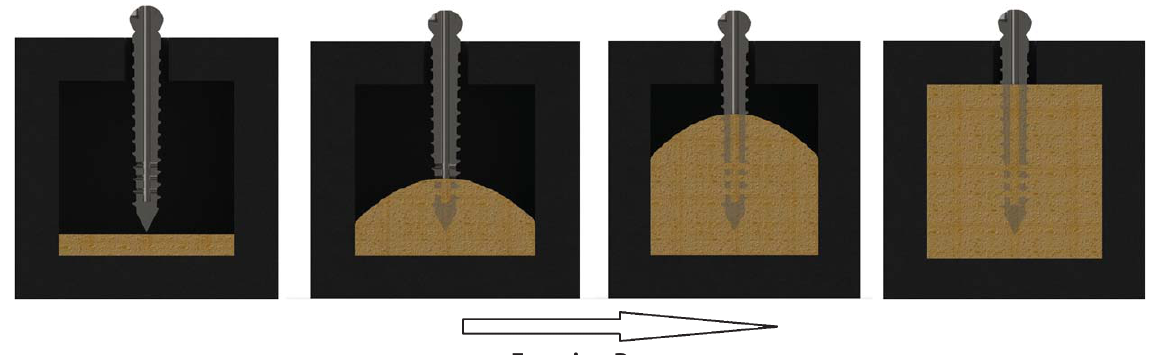
Fig. 3. Foaming Process: Simulation of bone fusion.